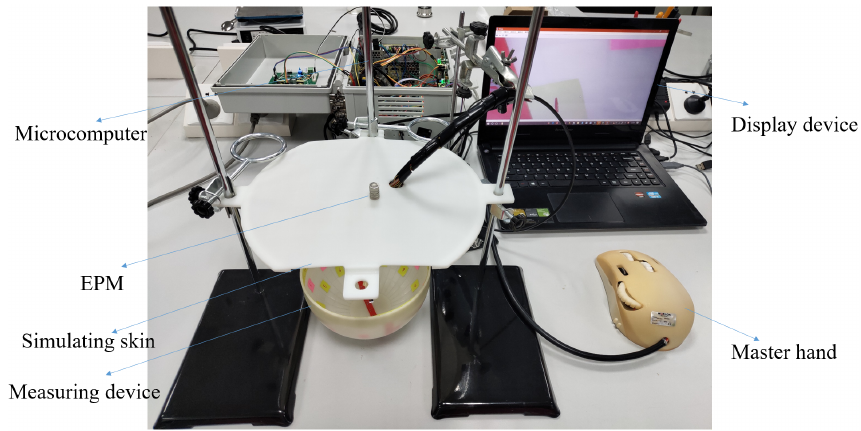
Figure 17. Experimental platform for evaluating the moveability of the